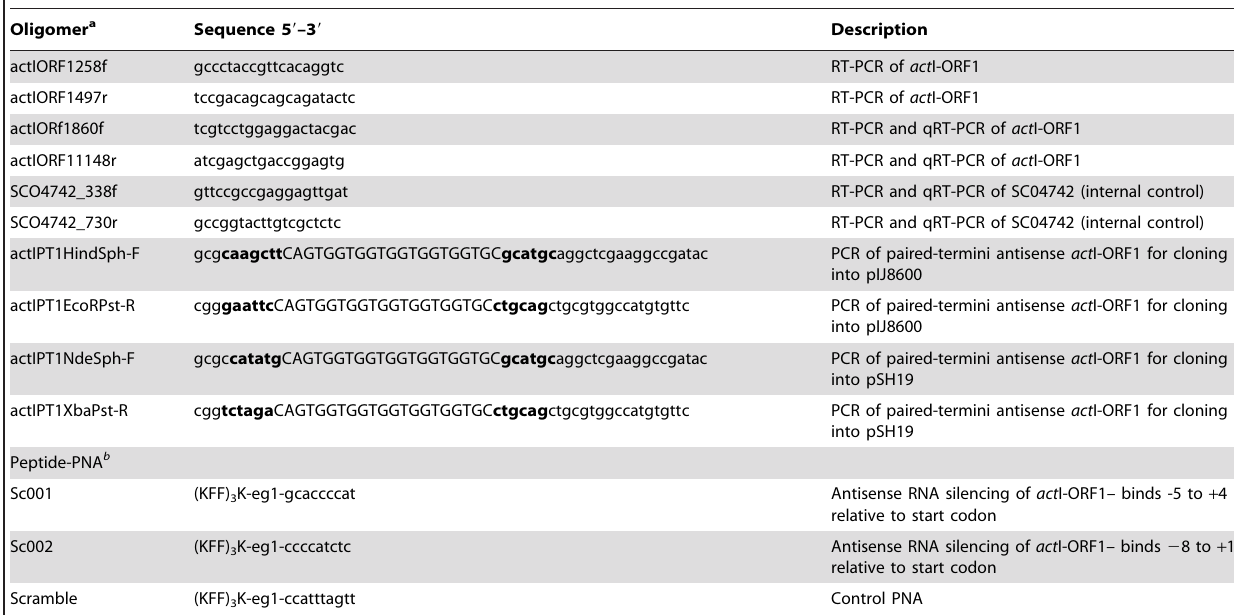
Table 2. Primers and peptide-PNAs used in this